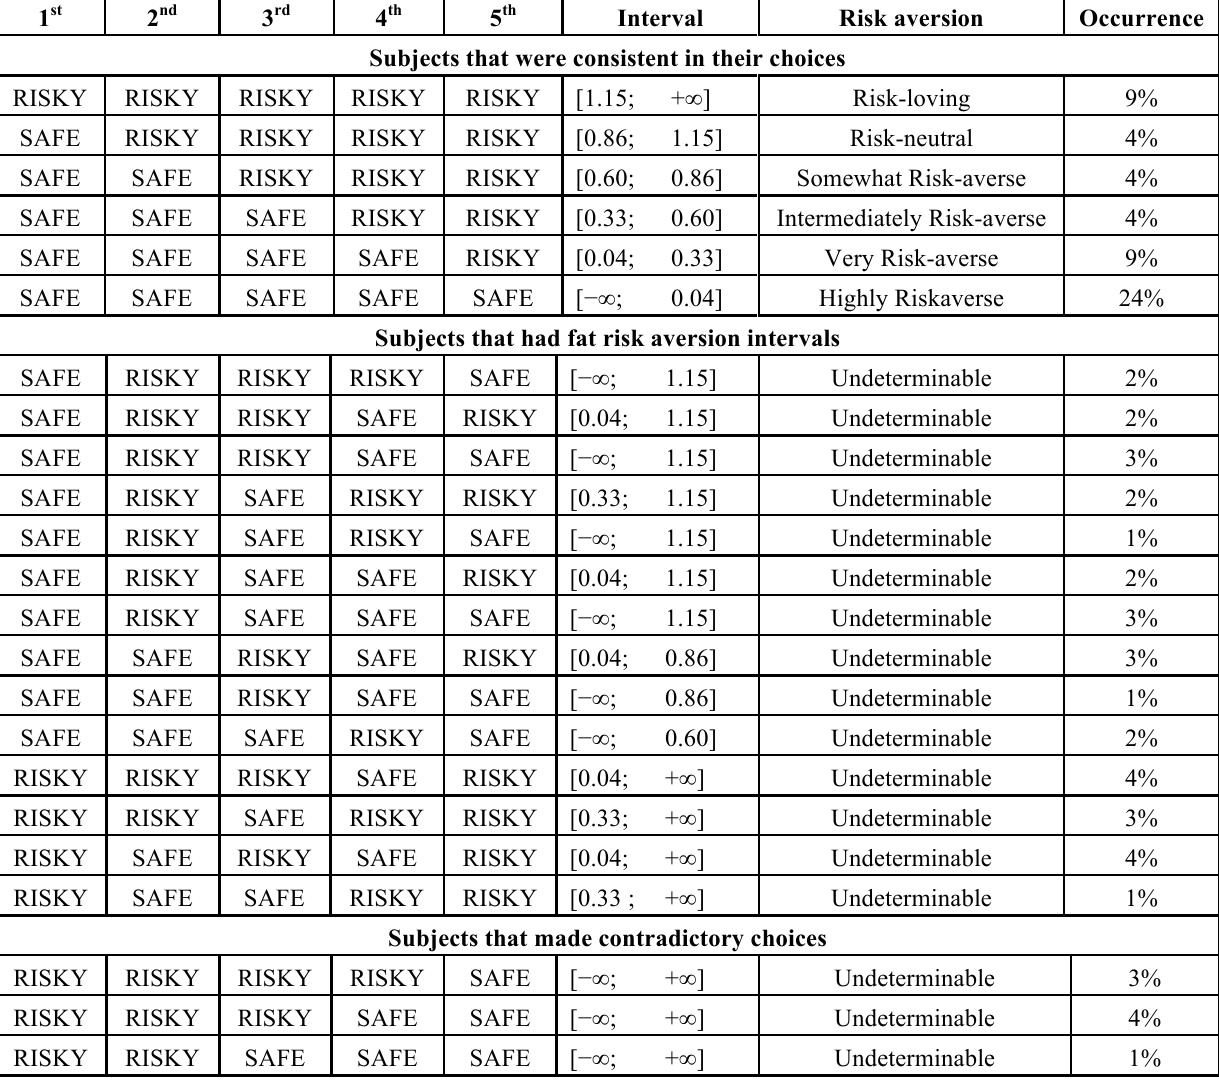
Table A1. The patterns of answers on the Holt-Laury test and the risk-aversion interval. 1 st 2 nd 3 rd Interval Subjects that were consistent in their